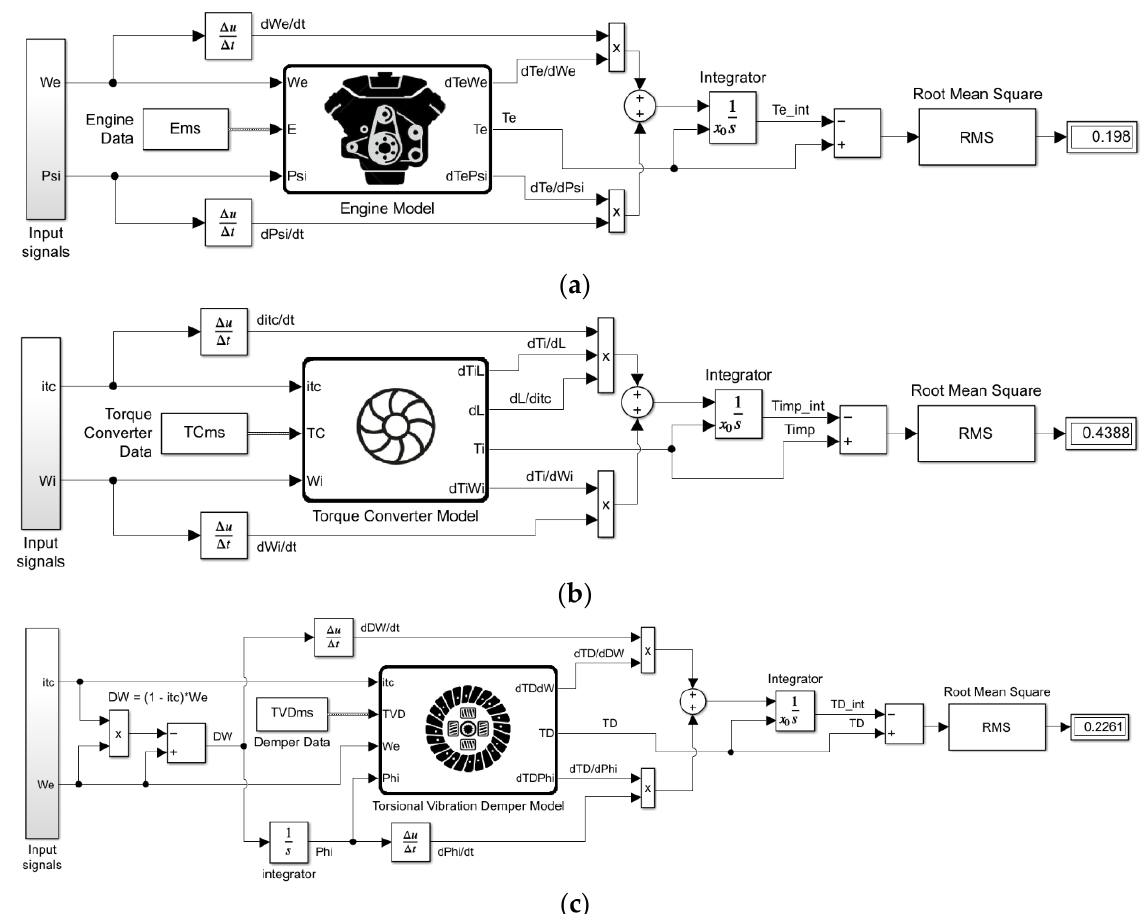
Figure 6. Comparing the moments’ values calculated directly and by integration for: ( a ) — engine model; ( b ) —TC model; ( c ) —damper model